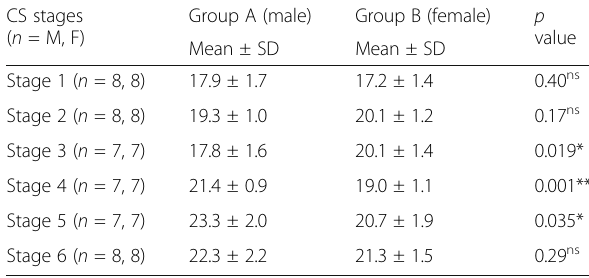
Table 5 Comparison of mean and standard deviation of BMI in different CS stages between group A and group